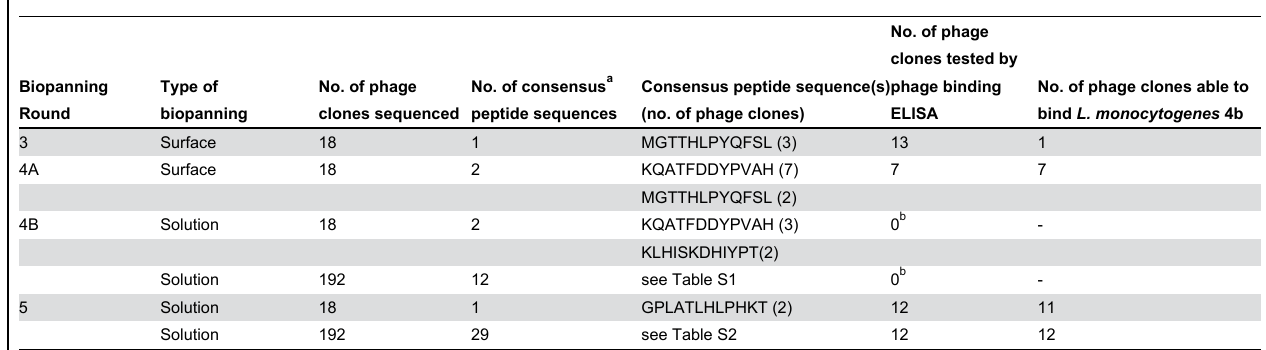
Table 2. Summary of biopanning outcomes.